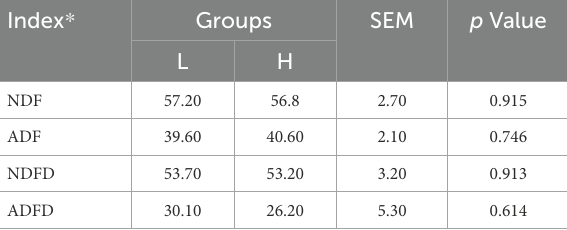
TABLE 2 Effects of MR levels of on fiber degradation rate of lambs